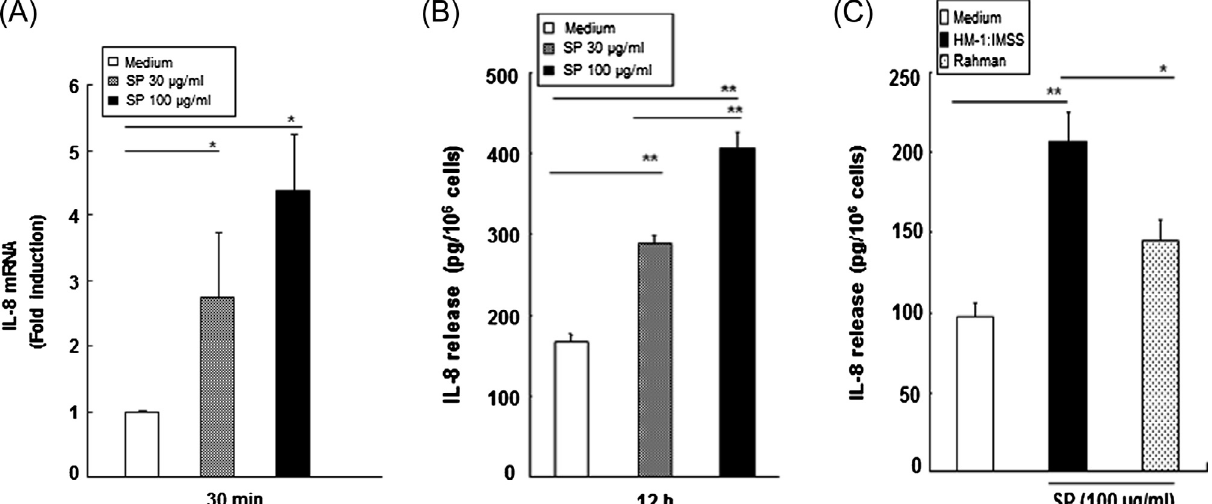
Figure 2. E. histolytica -derived secretory products (SPs) from the pathogenic wild-type HM-1:IMSS strain induce IL-8 gene expression and protein secretion in HMC-1 cells. (A) Increased IL-8 mRNA expression in HMC-1 cells induced by SPs. ( n = 3) (B) IL-8 production in SPs- stimulated HMC-1 cells. ( n = 6) (C) Comparison of IL-8 production in HMC-1 cells stimulated with SPs obtained from wild-type or non- pathogenic Rahman strains. ( n = 4). All reactions were performed in triplicate measurements of each experiment. Data are presented as the mean ± SEM of at least three independent experiments. The asterisks indicate the results of comparisons with the controls (* p < 0.05, ** p <